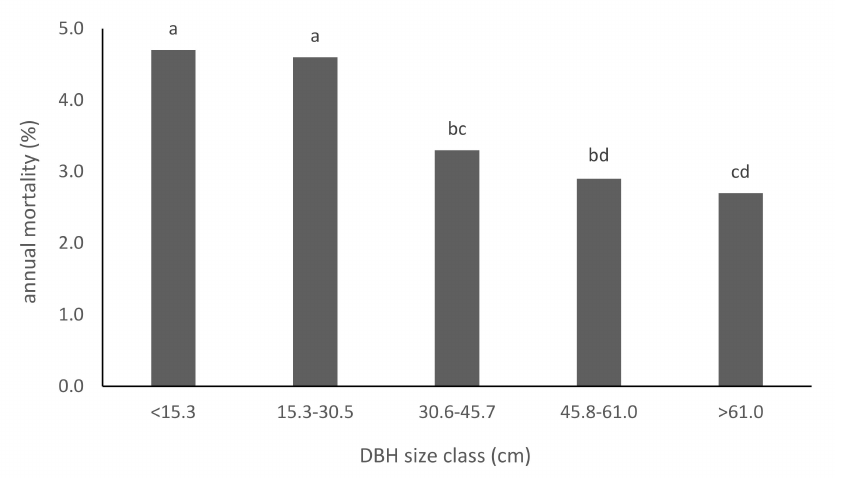
Figure 2. Annual mortality rates by DBH size class. Classes with the same letter are not significantly different. Table 2. Annual mortality rates by DBH size class (for the subset of 3657 trees in 2003 that had DBH